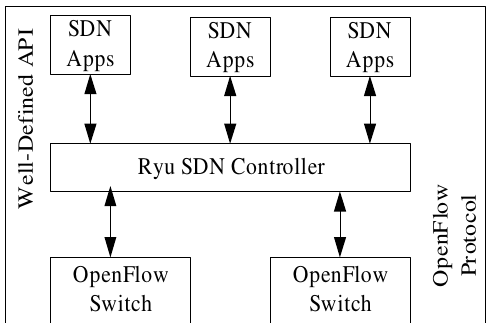
Figure 4. Ryu SDN